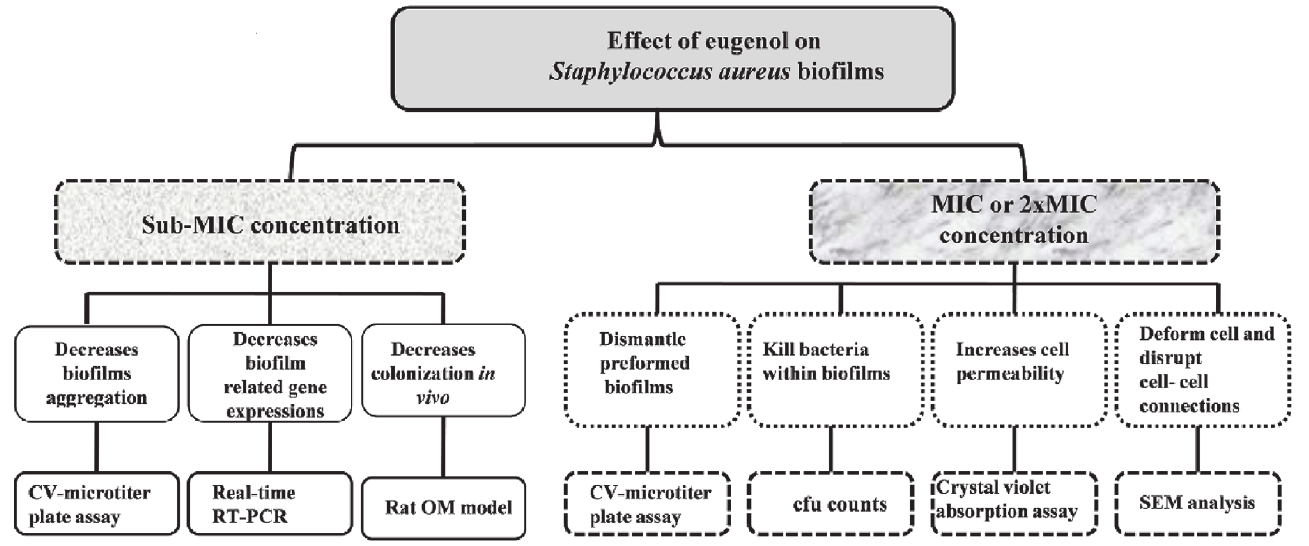
Fig 9. Systematic diagram showing effect of eugenol on Staphylococcus aureus